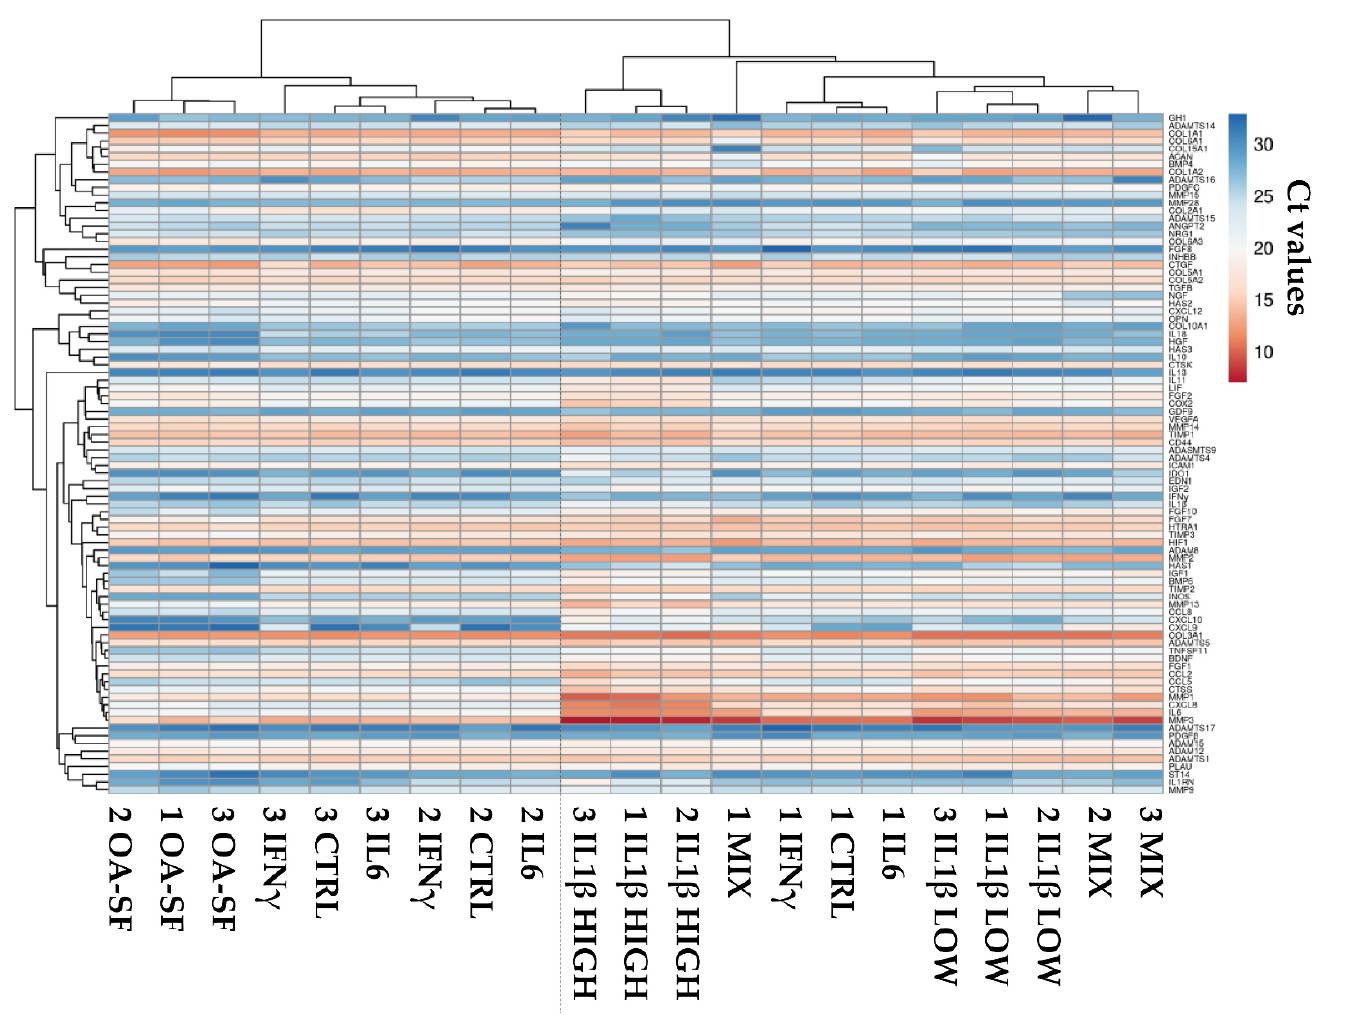
Figure 2. Heatmap showing differential expression of 88 genes between control (CTRL) and stress treatments (OA-SF for synovial fluid from OA-patients, IL1 β HIGH for 1 ng/mL IL1 β , IL1 β LOW for 100 pg/mL IL1 β , IL6 for 209 pg/mL IL6, for 86 pg/mL IFN γ and MIX for the three cytokines including IL1 β at low levels) in the three HCH donors. Red shades indicate higher expression and blue shades indicate lower expression. Color key indicates the intensity associated with normalized C t values.